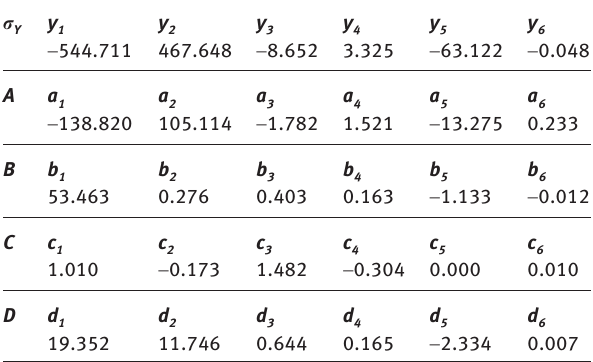
Table 4: Parameters obtained by surface fitting method